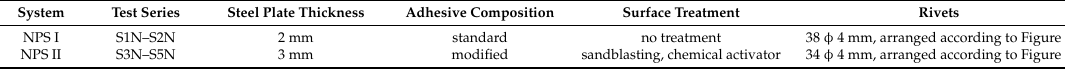
Figure 3. Arrangement of the rivets, S3N–S5N, series’ specimens (NPS II). Table 1. Differences between anchorages used in the NPS I and NPS II systems.